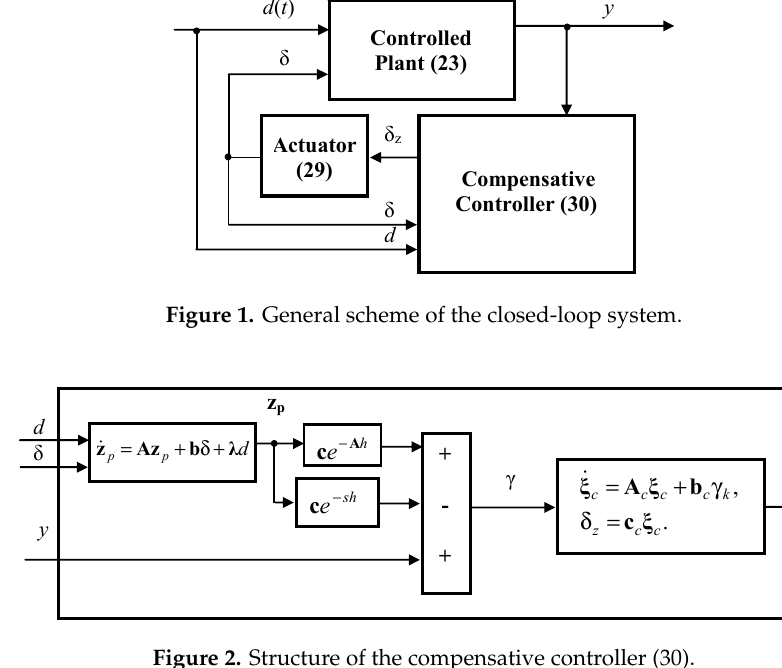
Figure 2. Structure of the compensative controller (30).